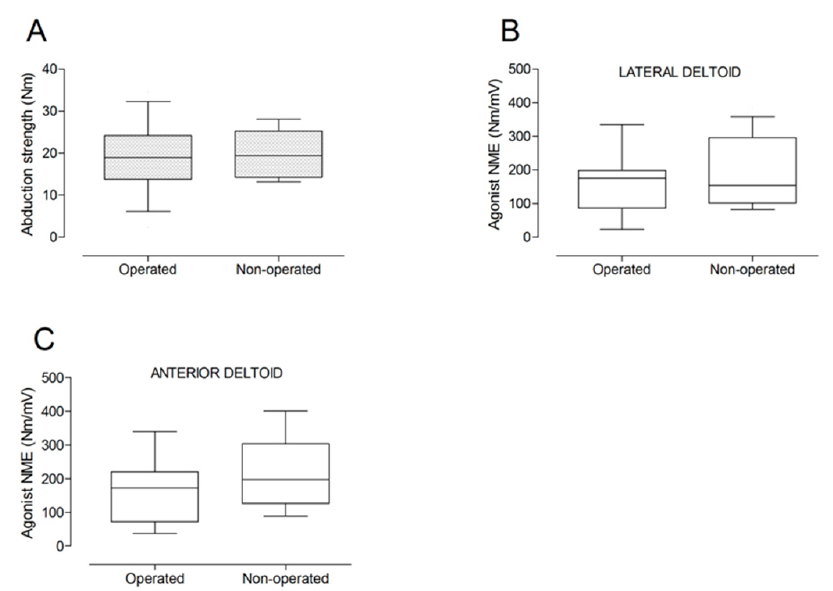
Figure 4. Box and whisker plots of shoulder abduction strength ( A ) and agonist neuromuscular efficiency (NME) of lateral deltoid ( B ) and anterior deltoid ( C ) muscles by side. The horizontal line in the box represents the median, the height of the box represents the interquartile range, and the distance between the opposite ends of the whisker represents the 10th–90th percentile.